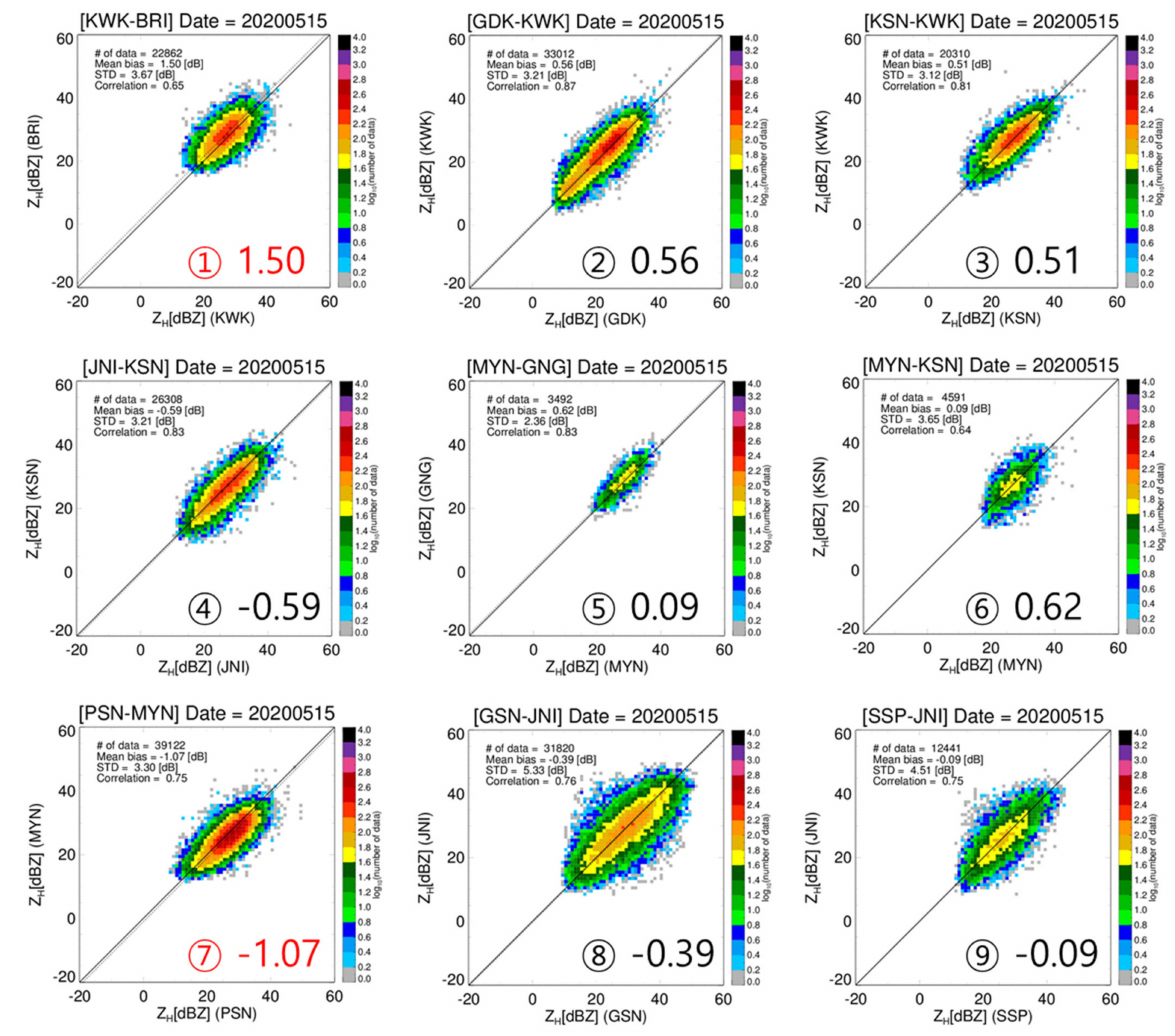
Figure 11. Same as Figure 10 after calibration bias correction. Figure 12 represents the mean bias before (triangles) and after (dots) applying ε SC to four rainfall events. These four events were widespread precipitation events passing through the Korean Peninsula. The red line indicates the mean bias within ± 1.0 dB. The mean bias before correcting ε SC shows a large inhomogeneity of Z H over the radar network. For CASE I, the mean biases of all radar pairs except for the GDK-KWK pair were greater than ± 1.0 dB. For the MYN-GNG, MYN-KSN, and PSN-MYN pairs, the mean biases were − 2.85, − 4.02, and 4.18 dB, respectively, due to the large calibration bias of MYN (3.64 dB). The mean biases were reduced from − 1.08 dB to 0.83 dB after correcting ε SC . For the JNI-KSN, GSN-JNI, and SSP-JNI pairs, the calibration of JNI ( − 6.73 dB) caused large mean biases (4.06 dB, − 4.89 dB, and − 6.94 dB). These mean biases were reduced to − 2.09 dB, 0.6 dB, and 0.69 dB after correcting ε SC . For CASE III and CASE IV, the mean bias